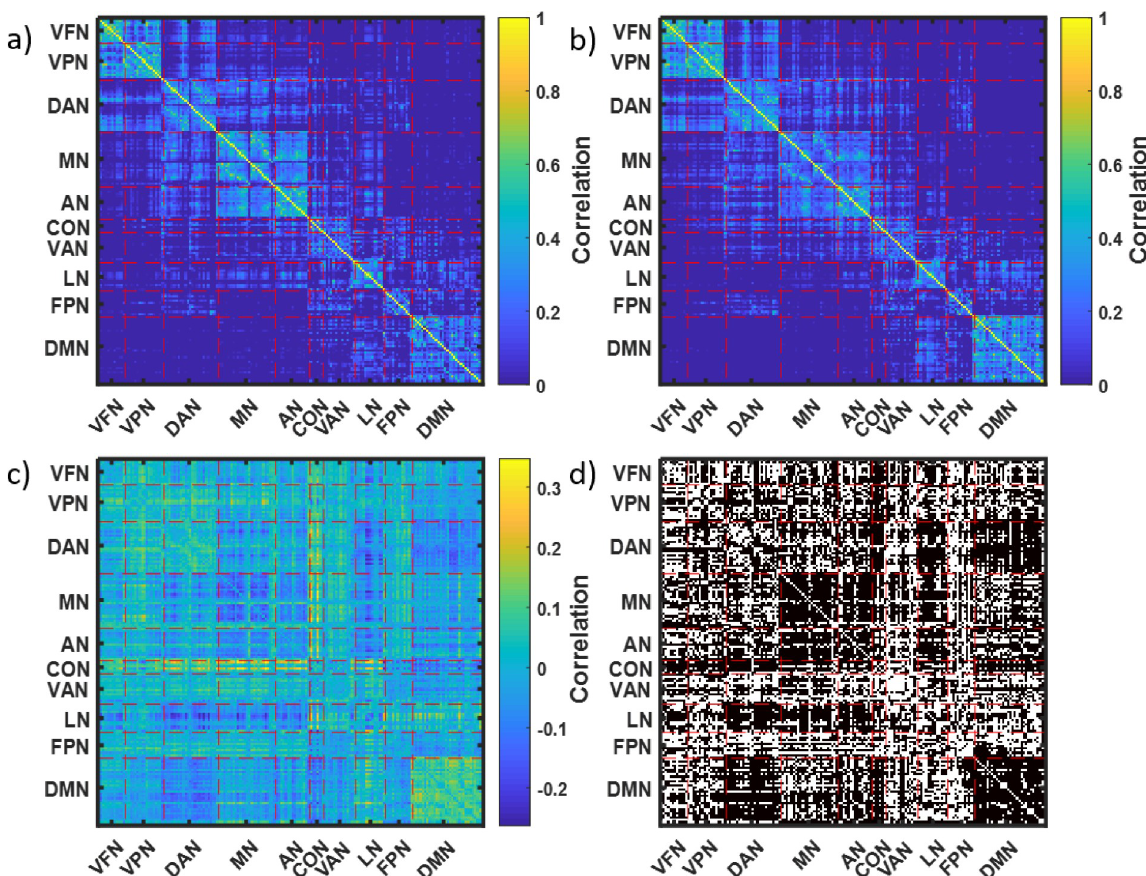
Fig 9. Mean brain connectivity matrices for two clusters identified in GSP data. A- Mean connectivity matrix for cluster 1, B- Mean connectivity matrix for cluster 2, C- Difference of mean connectivity matrices for cluster 2 and cluster 1, D- 8395 significantly different values of connectivity observed in cluster 1 vs. cluster 2. The 169 brain areas were divided into 10 networks: visual foveal (VFN), visual peripheral (VPN), dorsal attention (DAN), motor (MN), auditory (AN), cingulo-opercular (CON), ventral attention (VAN), language (LN), fronto-parietal (FPN), and default mode (DMN)